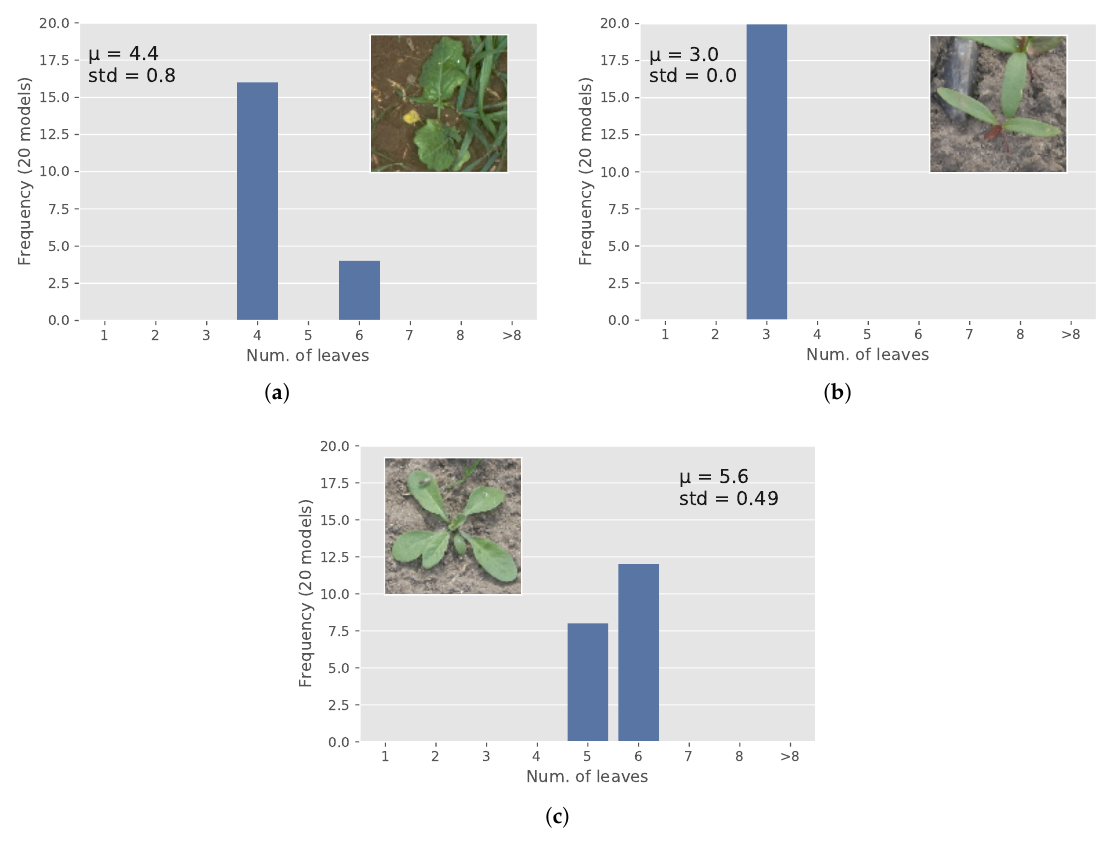
Figure 6. Estimating the number of leaves with different levels of confidence for three images; ( a ) hard case (std = 0.8); ( b ) simple case (std = 0); and ( c ) normal case (std = 0.49).